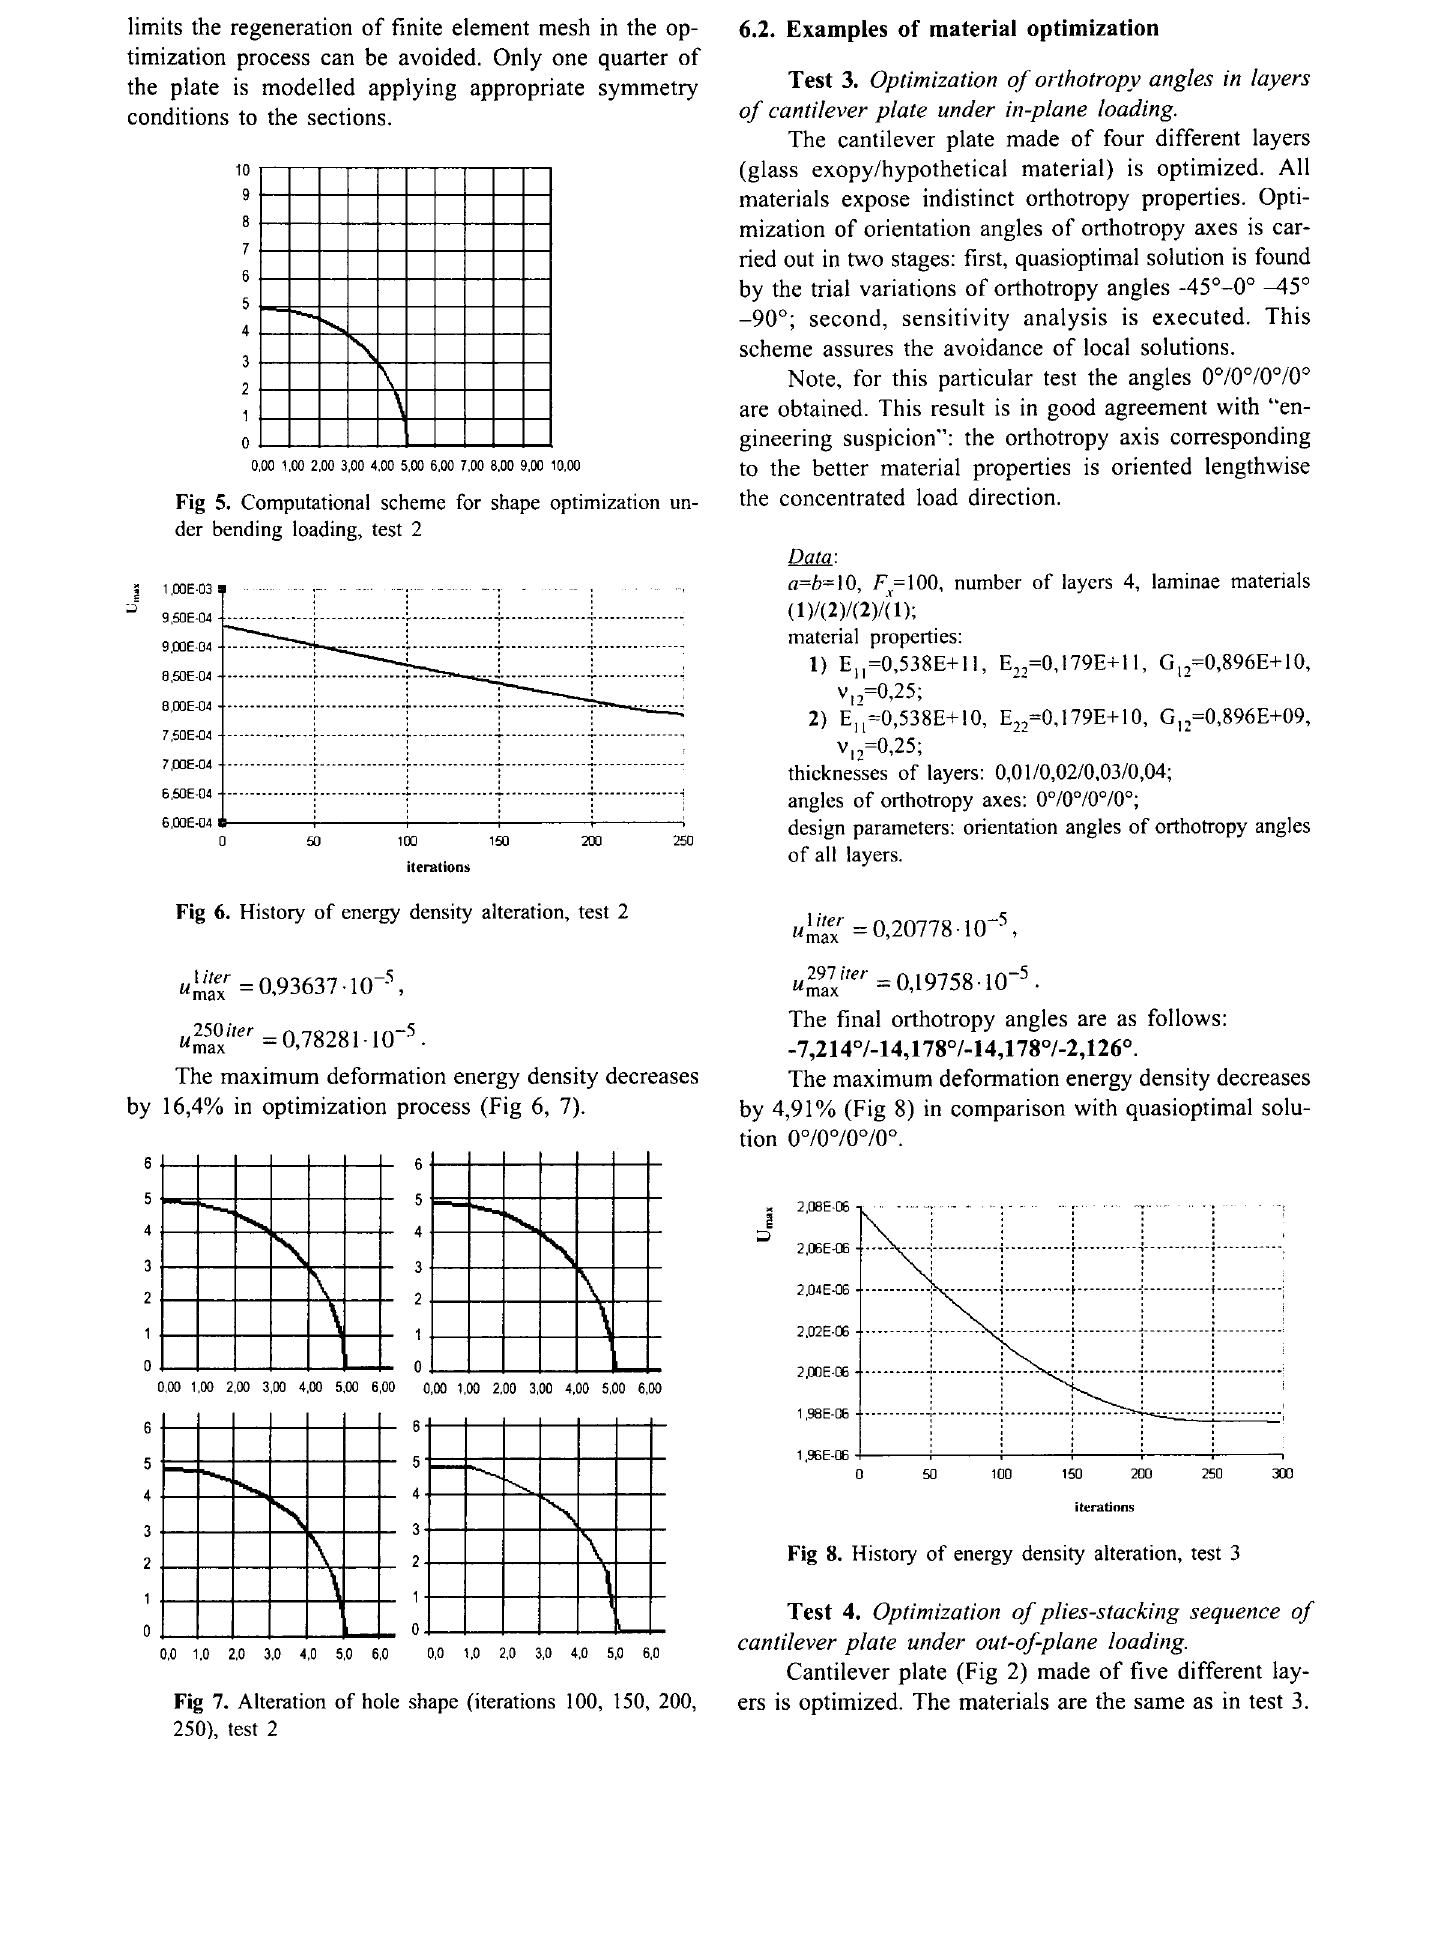
Fig 7. Alteration of hole shape (iterations 100, !50, 200, 250), test 2